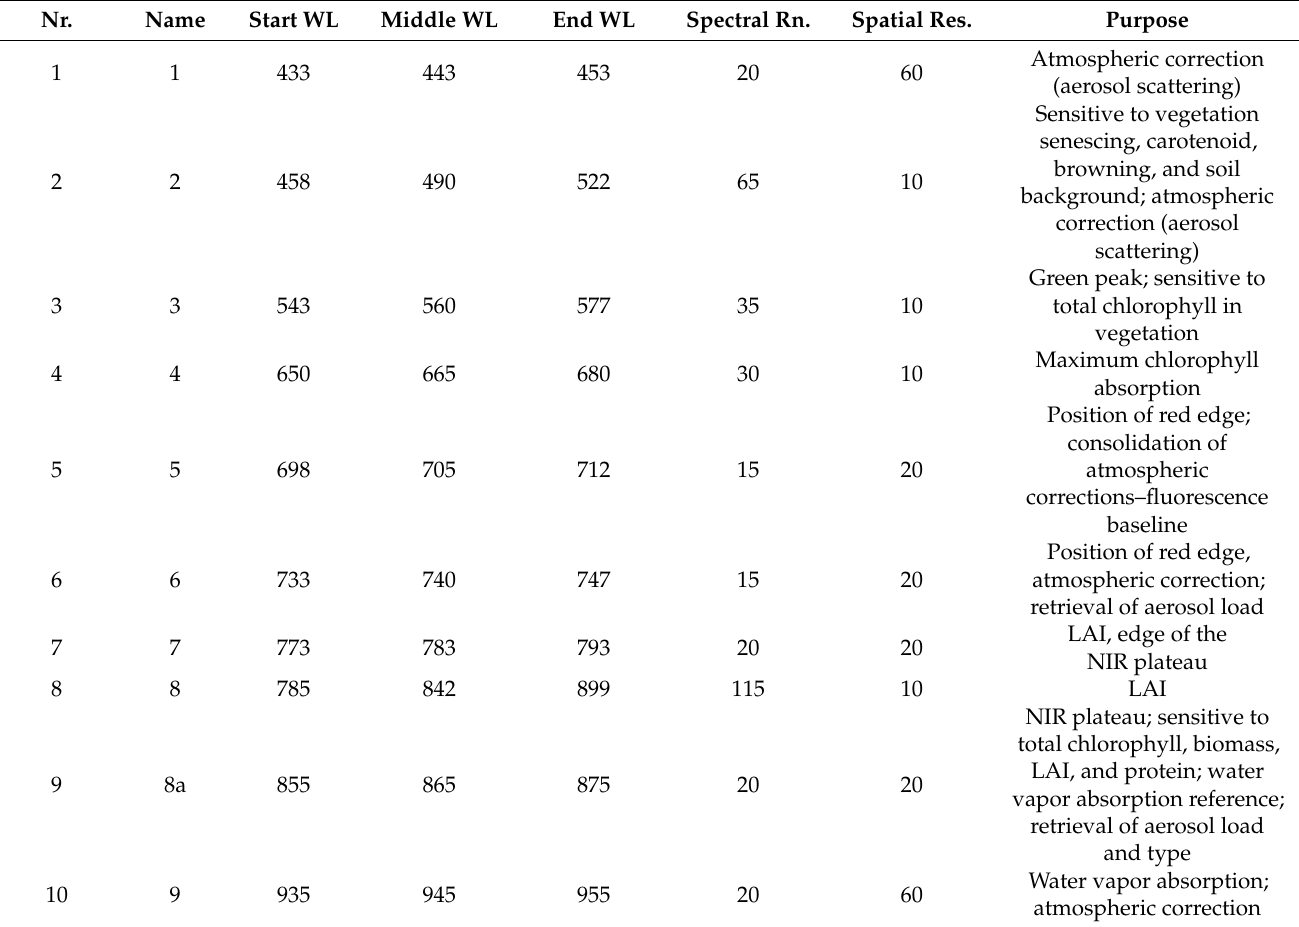
Table 1. Sentinel-2 MSI sensing bands range and purpose (Rn., range; Res., resolution; WL, wavelength) [20].